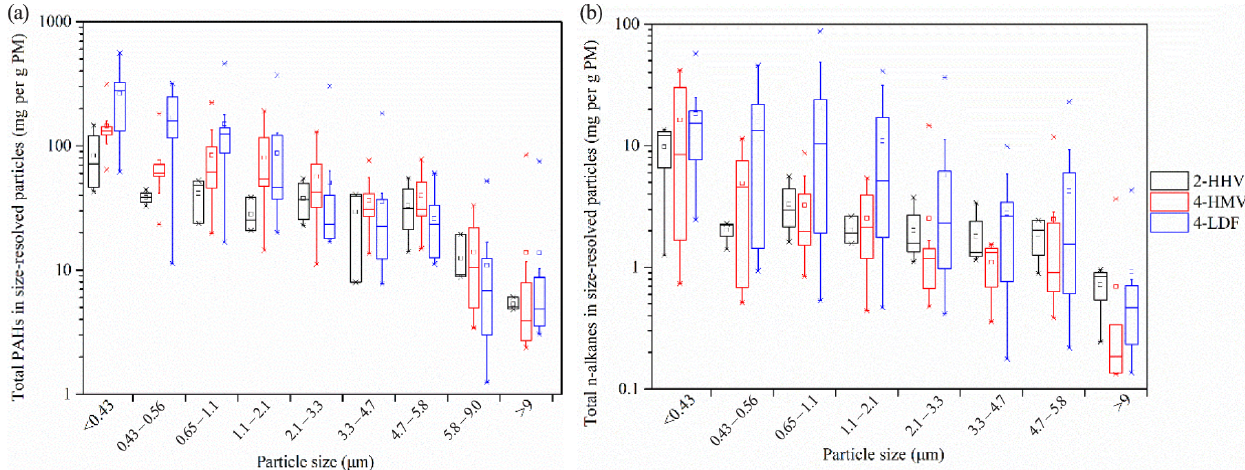
Figure 7. Emission ratios of total PAHs (in µg(g − 1 PM)) and n -alkanes (in mg(g − 1 PM)) in size-resolved